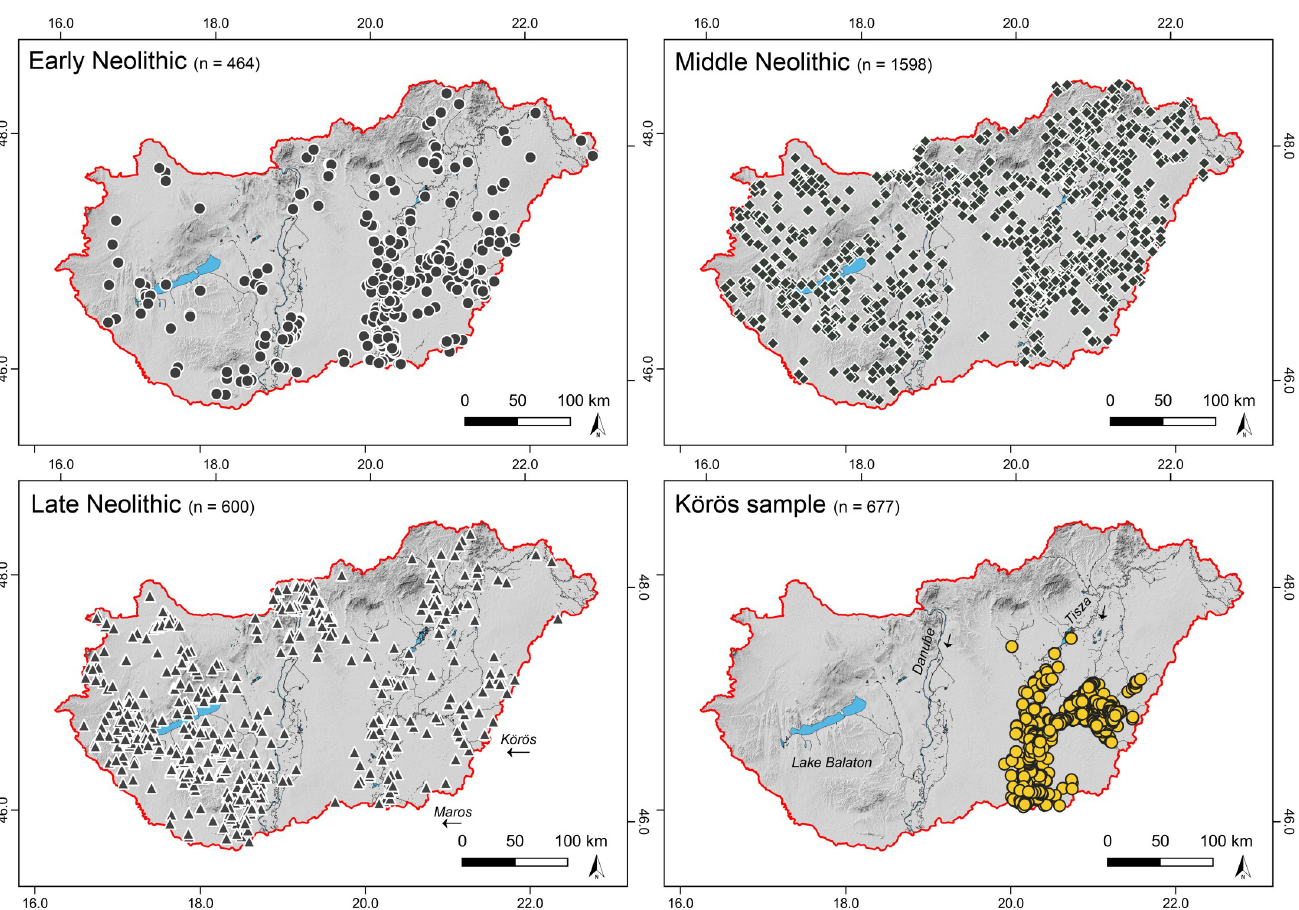
Fig 1. Distribution of the Early (EN), Middle (MN), and Late Neolithic (LN) sites in Hungary. The Early Neolithic Ko¨ro¨s sample is located along the rivers Tisza, Ko¨ro¨s, and Maros in the eastern part of modern Hungary (EN, MN, and LN sites provided by Attila Kreiter and the Hungarian National Museum at Budapest; Ko¨ro¨s sample based on Anders and Siklo´si,